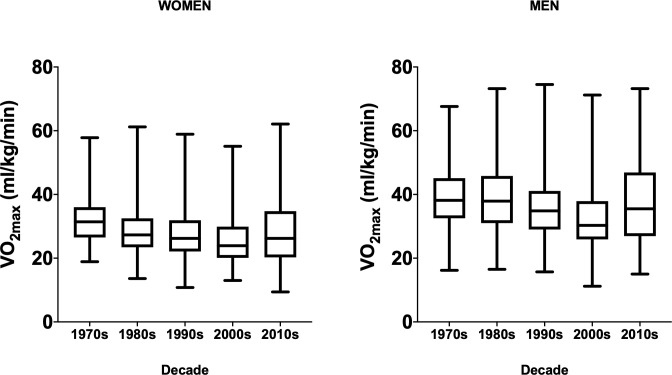
Box and whisker plots of relative VO2max
for women (left) and men (right). The box ranges from the 1st quartile to the 3rd quartile. The median is indicated by the line across the box. The whiskers start at the 1st or 3rd quartile and respectively end at the minimum or maximum values.